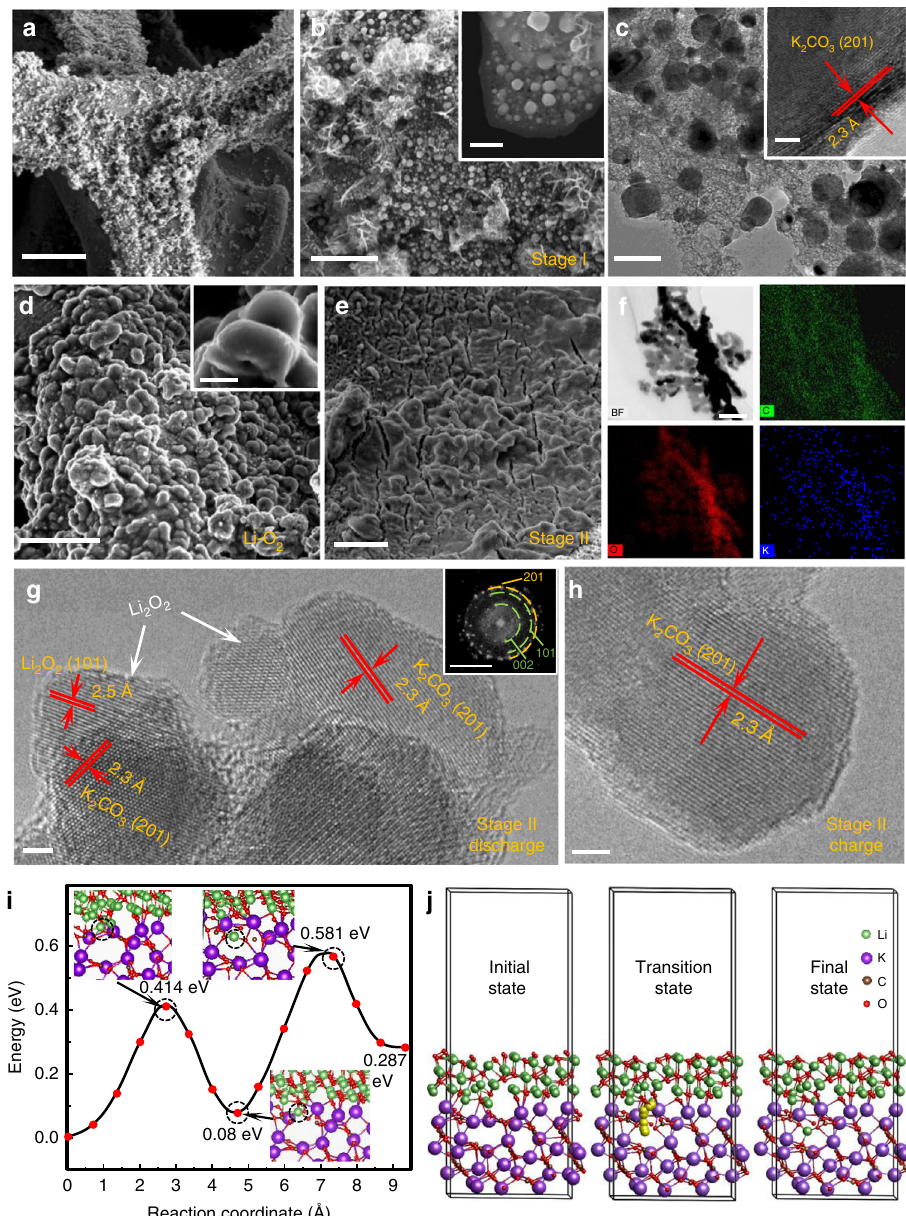
Fig. 4 Heterostructure. a – c SEM and TEM images of discharged PVP-C@LDO at stage I. Scale bars of a – c are 100 μ m, 2 μ m and 100 nm, respectively. Scale bars of insets in b , c are 500 nm and 2 nm, respectively. d SEM image of discharged PVP-C@LDO in conventional Li – O 2 battery. Scale bar, 5 μ m. Scale bar of inset in d is 500 nm. e – g SEM, elemental mapping and HRTEM images of discharged PVP-C@LDO at stage II. h HRTEM image of charged PVP- C@LDO at stage II. Scale bars of e , f , g , and h are 5 μ m, 50 nm, 2 nm, and 2 nm, respectively. Inset in g is the corresponding fast Fourier transformed image with scale bar of 5 nm − 1 (green: Li 2 O 2 ; yellow: K 2 CO 3 ). i Energy barrier pro fi le of Li + migration through heterojunction of Li 2 O 2 (101)/K 2 CO 3 (201). The migration of Li + is marked as black dotted circle. j Li + migration pathways into K vacant site of K 2 CO 3